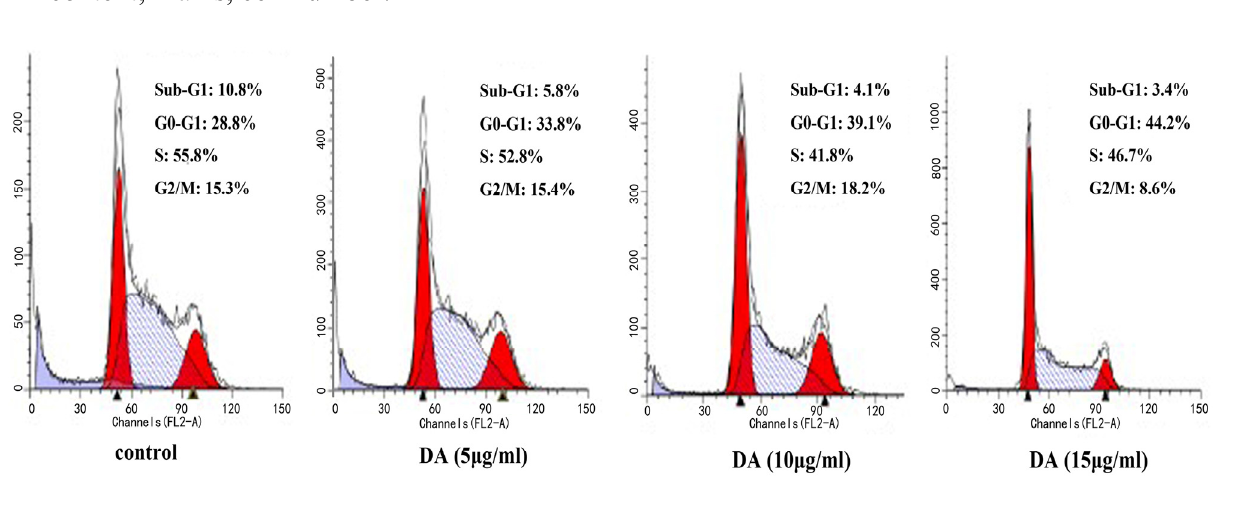
Figure 3. Effect of DA on cell cycle distribution. HCT-116 cells were harvested for cell cycle analysis using propidium iodide staining after incubated for 15 min. X axis, DNA content; Y axis, cell